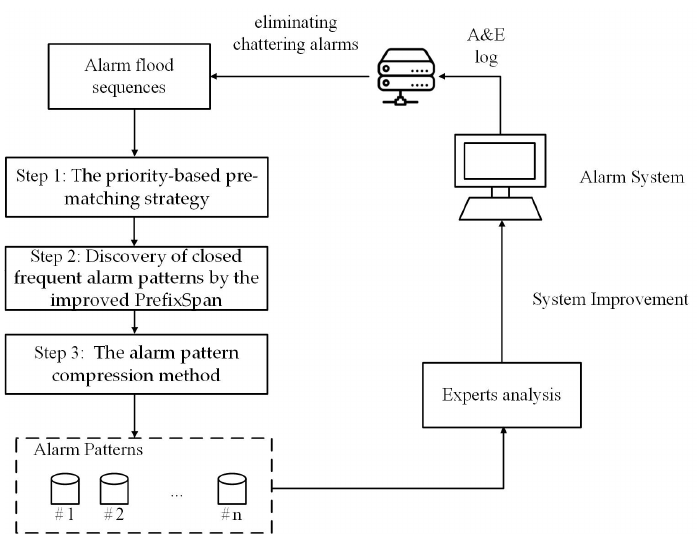
Figure 2. Framework of the proposed method for mining alarm pa tt erns.